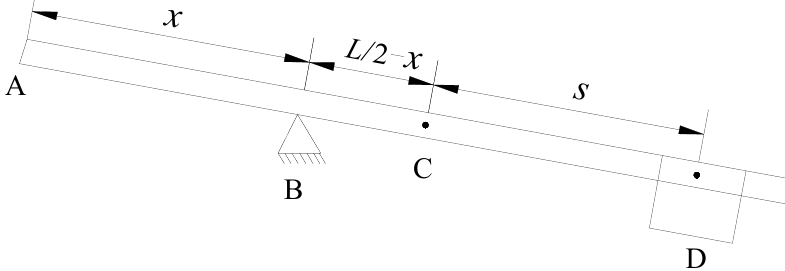
Figure 6. Simplified model for calculating the moment of inertia: A is the front of the drive arm; B is the rotation axis; C is the mass center of the drive arm; D is the counterweight-installed position; x is the distance between A and B (mm); L is the length of the drive arm (mm); and s is the distance between C and D (mm).